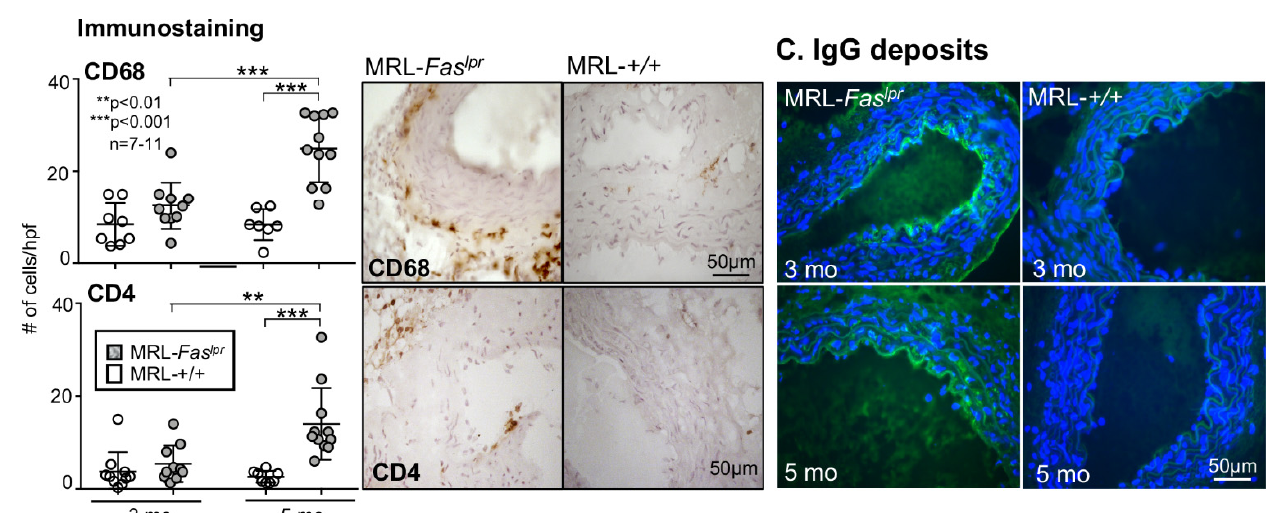
Figure 2. Marked increase in intima–media thickness of aorta and infiltration of vessel wall with macrophages and T cells in MRL- Fas lpr mice. ( A1 ). Intima-media thickness of the aorta in MRL- Fas lpr compared with MRL-++ mice at 3 and 5 mo of age (*107.81 Pixel and *58.31 Pixel) ( A2 ) Foam cells in cell vessel wall of MRL- Fas lpr mice at 5 mo of age. Representative microphotographs are shown (magnification 20 × , enlargement 40 × ). Arrows denote foam cells. ( B ) Infiltration of the vessel wall with CD68 + macrophages and CD4 + T cells determined by RTQ-PCR (age 1, 3, and 5 mo of age for MRL- Fas lpr ) as well as by immunostaining (3 and 5 mo of age). Representative microphotographs are shown (magnification 20 × , enlargement 40 × ). hpf, high-power field. ( C ) IgG deposits on the blood vessel wall of MRL- Fas lpr mice compared to MRL-++ mice at 3 and 5 mo of age. In all experiments n = 5–15 mice per group. Values are means ± SEM. Statistical analysis using Mann–Whitney U